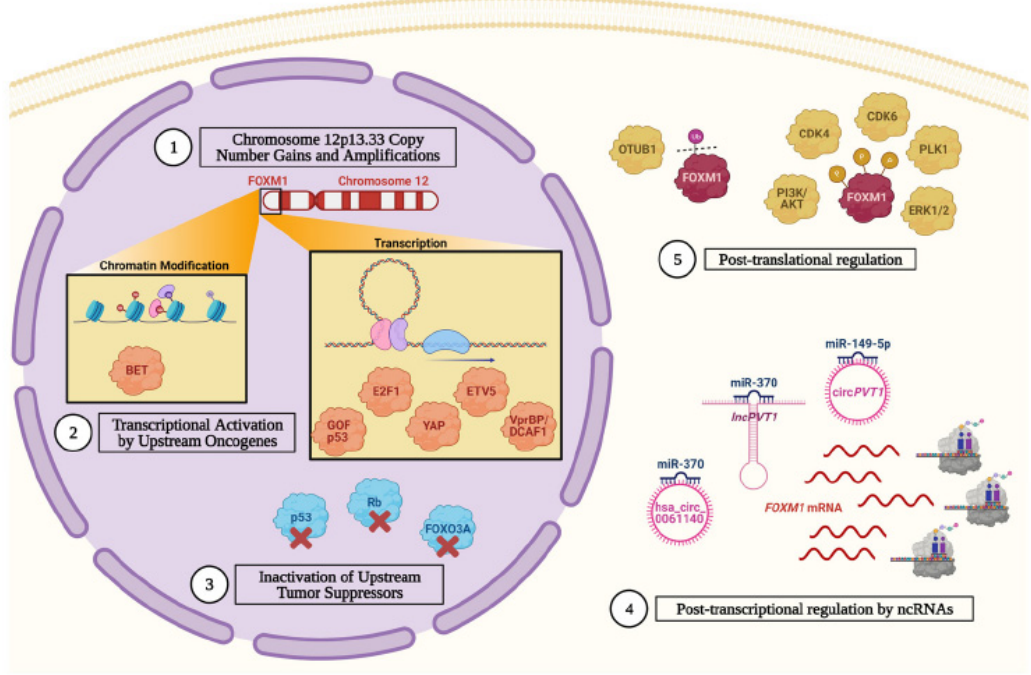
Figure 3. Mechanisms leading to FOXM1 overexpression and activation in ovarian cancer. Several mechanisms that are known to result in FOXM1 overexpression and/or activation in ovarian cancer are shown: (1) Chromosome 12p13.33, where the FOXM1 gene resides, experiences copy number gains and amplifications. (2) Upstream oncogenes (BET, GOF p53, E2F1, YAP, VprBPDCAF1, and ETV5) are overexpressed and upregulate FOXM1 transcription through chromatin modification and promoter activation. (3) Upstream tumor suppressors that regulate FOXM1 transcription (p53, Rb, and FOXO3A) experience inactivation through gene mutation or loss. (4) Post-transcriptional regulation by ncRNAs allow ribosomes to translate high levels of FOXM1 mRNA miR-370 and miR-149-5p, which typically destabilize FOXM1 mRNA, are sponged by lnc PVT1 , circ PVT1 , and hsa_circ_0061140. (5) Post-translation regulation stabilizes and activates FOXM1 protein. OTUB1 deubiquitinates FOXM1 and increases protein stability. PI3K/AKT, CDK4, CDK6, PLK1, and ERK1/2 phosphorylate FOXM1, which activates its transcription factor function. Figure created with BioRender.com.